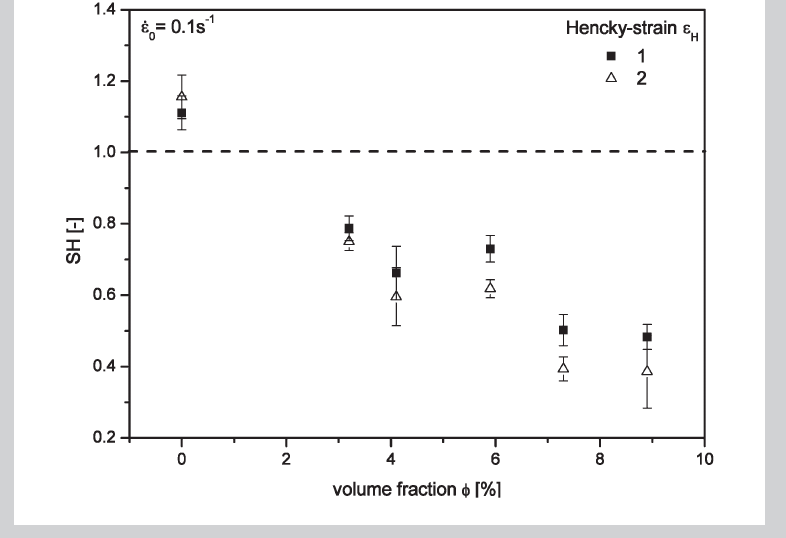
Figure 4 (above): Strain hardening factor of PMMA / nano-clay compos- ites at 180°C. Figure 5: Elongational rate as a func- tion of time in creep experi- ments at two different stresses on neat PMMA (a and b) and PMMA / 7.3 vol% clay (c and d) at